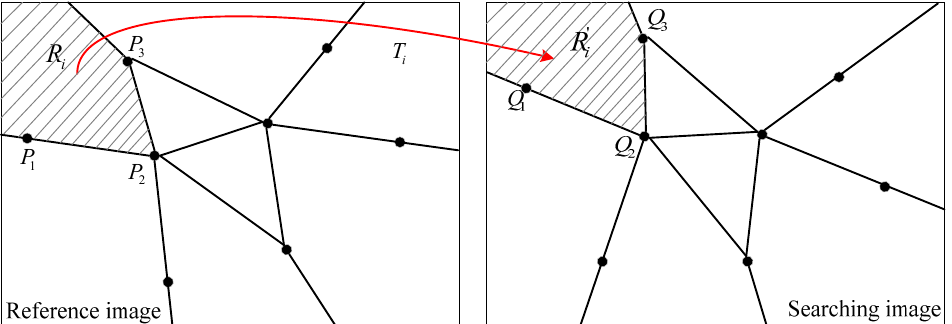
Figure 6. Outliers elimination based on local geometric constraint. The extension Delaunay triangles are constructed in each image based on the matches in S p . Images are divided into many pairs of corresponding sub-regions. R i and R (cid:48) are a pair of corresponding sub-regions. P 1 Q 1 , P 2 Q 2 , and P 3 Q 3 i are three pairs of matches constructing the two corresponding sub-regions R i and R (cid:48) . T i denotes the i affine transformation between R i and R (cid:48) computed by the three pairs of i